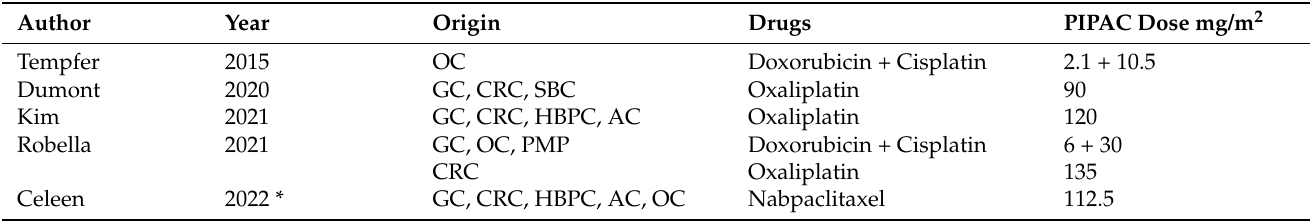
Table 2. Phase I dose escalation studies on PIPAC